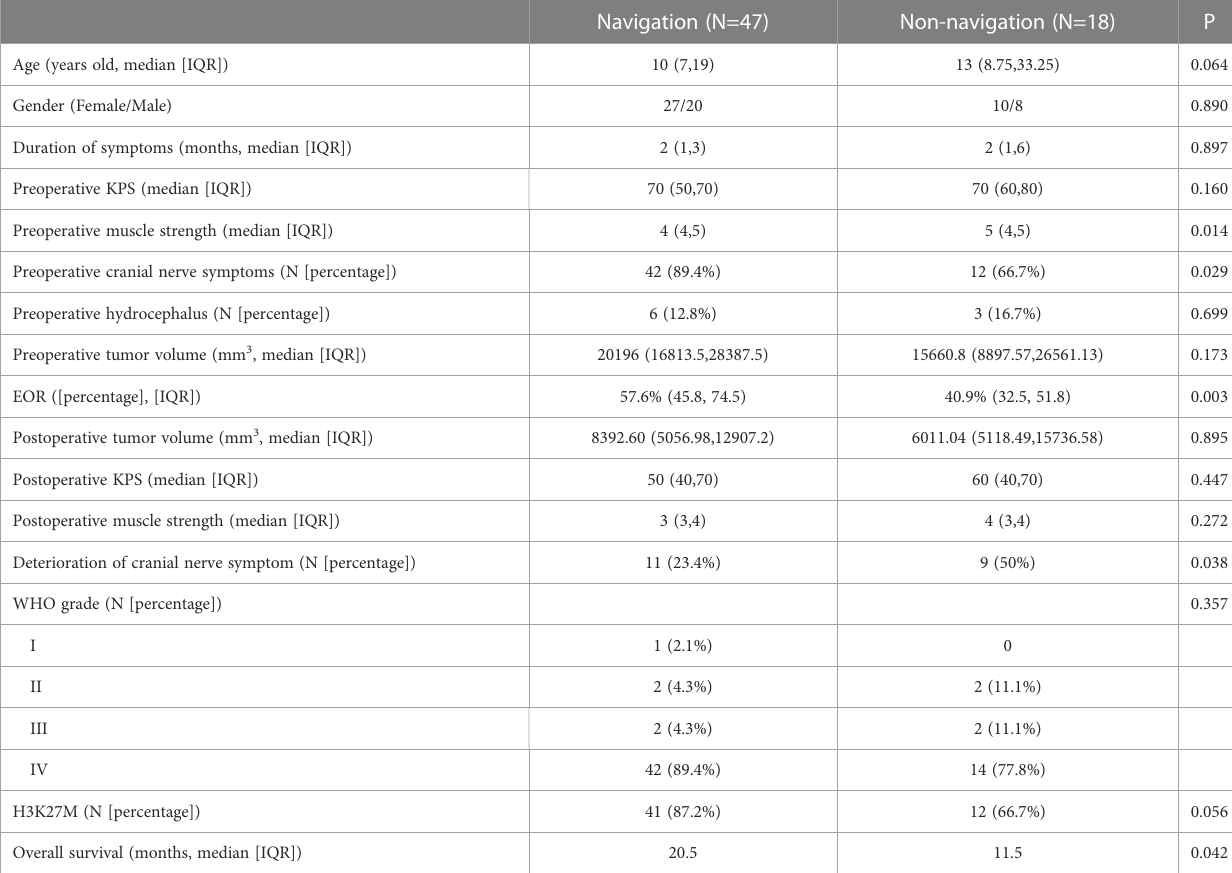
TABLE 2 The summary of included patients (DIPG).